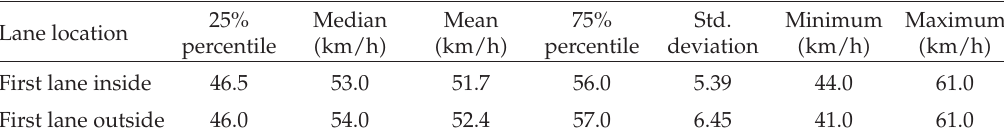
Table 2: The statistical result of speed before